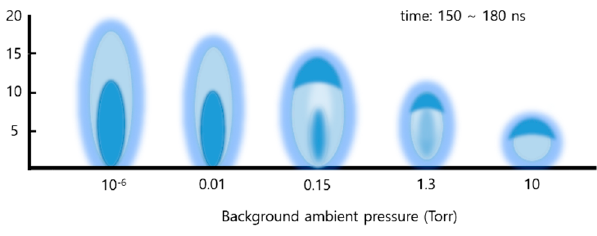
Figure 6. Schematic of various shapes of laser-induced plasma with respect to the ambient pressure.